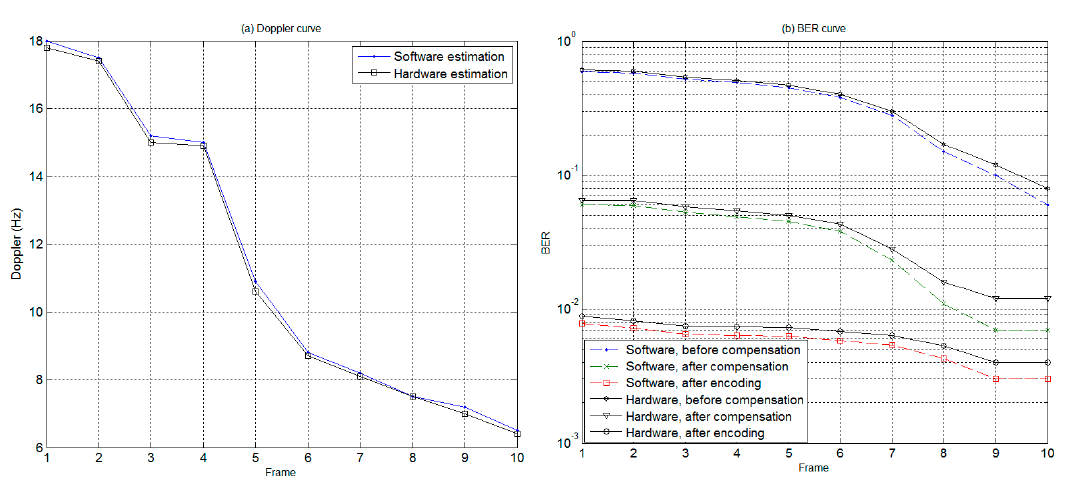
Figure 9. Doppler and bit error rate (BER) curves obtained with software and hardware approaches. ( a ) Doppler curve ( b ) BER curve.